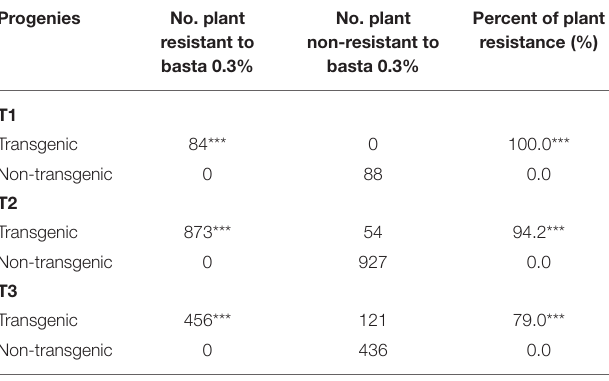
TABLE 3 | Evaluation of the potential ability of VX93 transgenic lines to herbicide resistance (Basta 0.3%) in T1 to T3 generations under field condition.